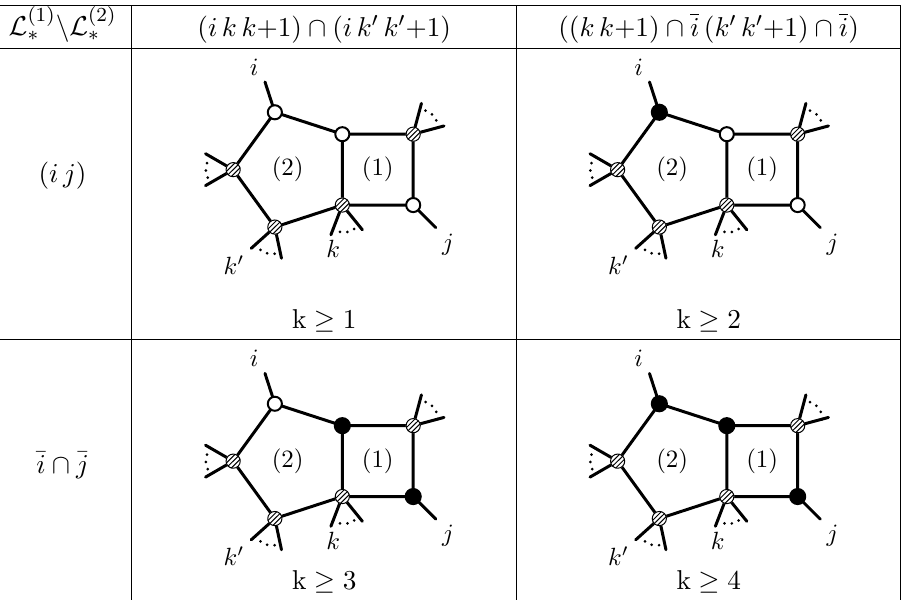
Table 8 . All permissible colorings of the trivalent nodes of the two-loop pentagon-box Landau diagram from table 2(a). The (cid:12)rst row shows the two possible solutions to the three-mass on-shell (2) , the loop momentum in the pentagon. The (cid:12)rst column conditions (eq. (4.10)) satis(cid:12)ed by L shows the two possible solutions to the two-mass easy on-shell conditions (eq. (4.11)) satis(cid:12)ed by (1) , the loop momentum in the box. The cell at the intersection of a row and a column is the L colored Landau diagram that results from the two solutions. Also indicated in each cell is the minimum helicity sector of the colored Landau diagram, which is achieved only if the gray nodes are taken to be